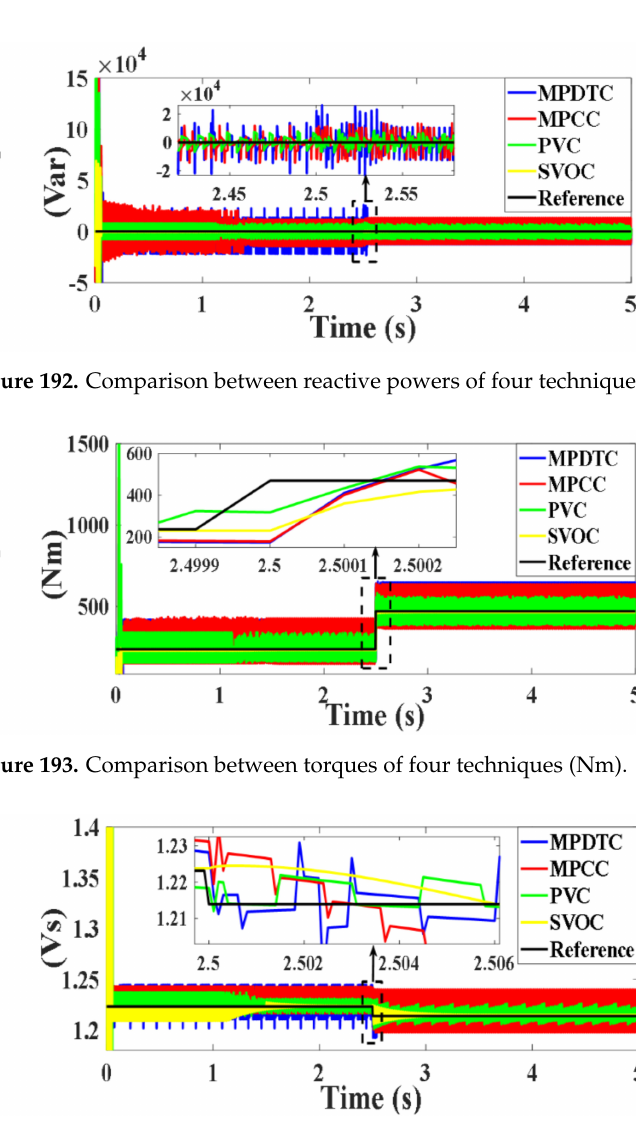
Figure 194. Comparison between rotor fluxes of four techniques